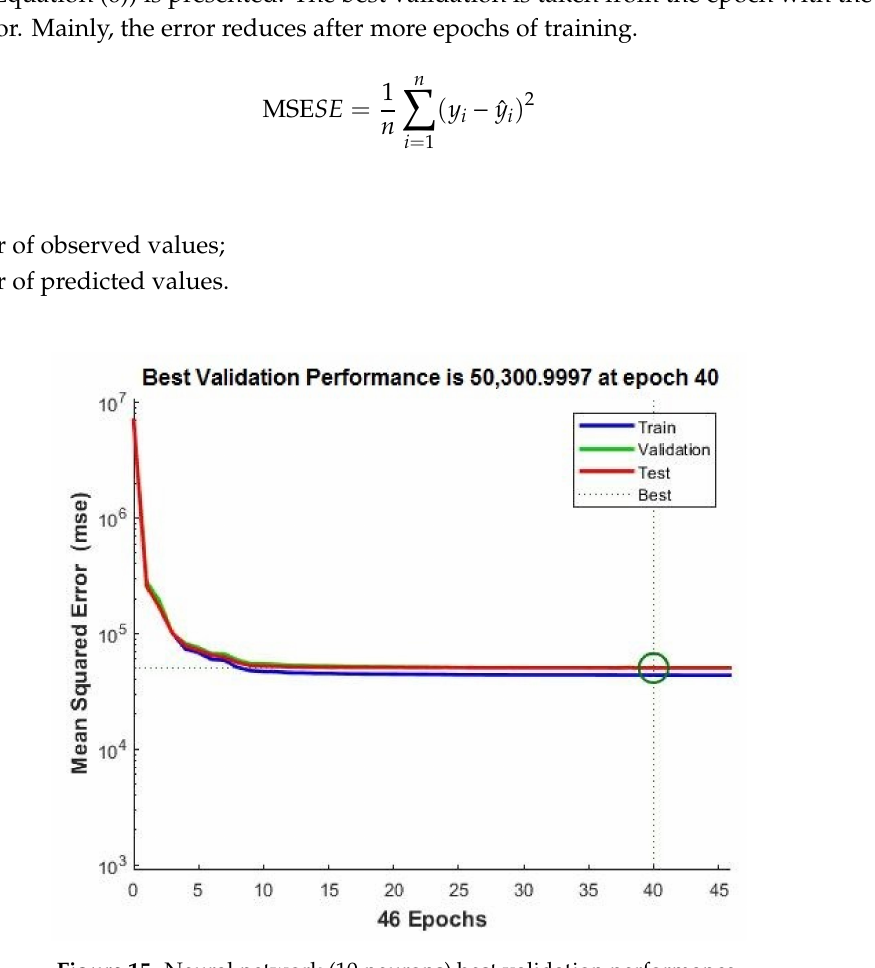
Figure 15. Neural network (10 neurons) best validation